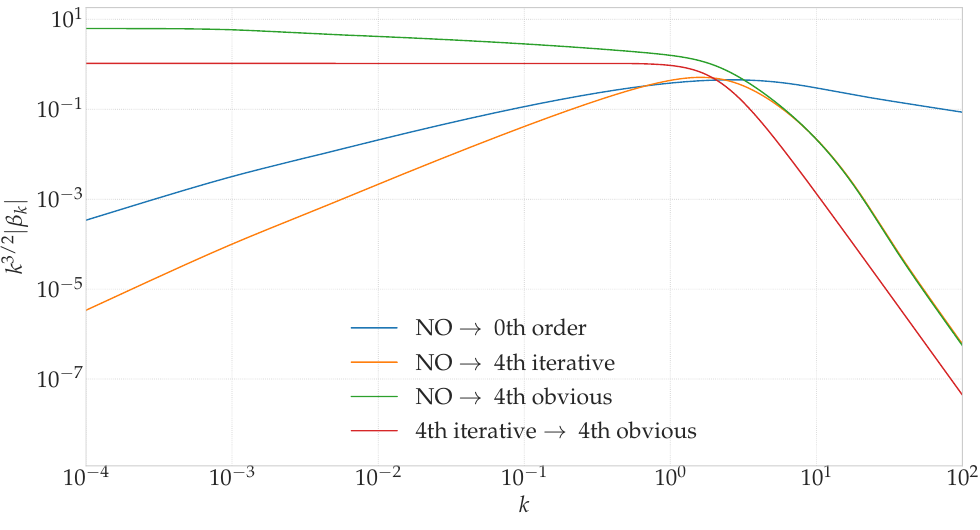
Figure 7. Norm of the beta coefficients, multiplied by k 3/2 , for different Bogoliubov transformations relating adiabatic states of the obvious and iterative types and the